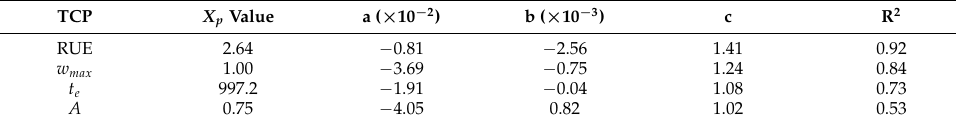
Table 3. Empirical coefficients (a, b, and c) of a multilinear function ( FR = a × dT 1 + b × dT 2 +